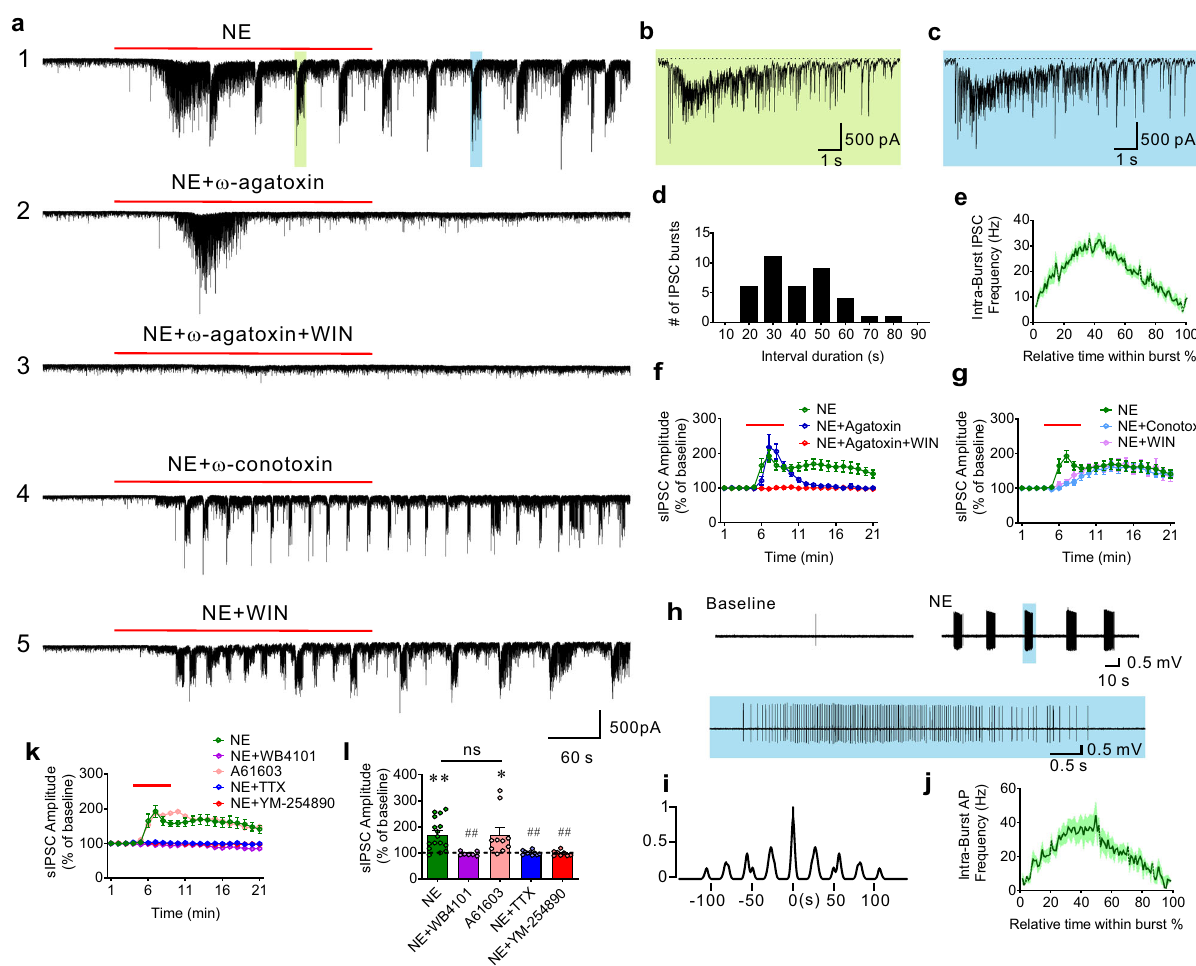
Fig. 3 α 1A adrenergic receptor activation of PV interneurons generates phasic IPSC bursts in BLA principal cells. a1 – 5 Representative recordings showing the effect of different treatments on NE-induced repetitive IPSC bursts in the BLA principal neurons. 1 . NE application induced phasic IPSC bursts following an initial increase in IPSCs. 2 . Inhibiting PV neuron-mediated transmission with the P/Q calcium channel blocker ω -agatoxin selectively blocked the NE-induced repetitive IPSC bursts, but not the initial increase in IPSCs. 3 . Co-application of ω -agatoxin and the CB1 receptor agonist WIN 55,212-2 blocked both the initial increase in IPSCs and the repetitive IPSC bursts. 4 . Pretreatment of a slice with the N-type calcium channel blocker ω -conotoxin selectively inhibited the initial increase in IPSCs induced by NE, but not the repetitive IPSC bursts. 5 . Application of the CB1 receptor agonist WIN 55,212-2 blocked the NE-induced initial IPSC increase but did not affect the repetitive IPSC bursts. b , c Expanded traces of individual IPSC bursts in a1 (indicated with green and blue shading), showing the fast acceleration in the intra-burst IPSC frequency and resulting depression in the baseline holding current (indicated with dashed lines) induced by NE. d Histogram showing the distribution of phase durations of NE-induced repetitive IPSC bursts. 10-s bins from time − 5 s to + 5 s. ( n = 38 bursts from 16 cells, 5 mice). e Mean (±SEM) instantaneous intra-burst IPSC frequency over the course of the NE-stimulated accelerating IPSC bursts ( n = 38 bursts from 16 cells, 5 mice). f Time course of the effect of blocking P/Q-type calcium channels and activating CB1 receptors on sIPSC amplitude. The NE-induced plateau increase in sIPSC amplitude (mean ± SEM) was blocked by ω -agatoxin (P/Q blocker), while the peak increase, corresponding to the NE-induced initial increase in IPSCs shown in a2 , was unaffected ( n = 10 cells from 4 mice). The ω -agatoxin-insensitive IPSCs were blocked by CB1 receptor activation with WIN 55,212-2 ( n = 8 cells from 3 mice), corresponding to the recording in a3 . g Time course of the effect of blocking N-type calcium channels and activating CB1 receptors on sIPSC amplitude (mean ± SEM). Both treatments selectively eliminated the NE-induced initial increase in IPSCs, with little effect on NE-induced repetitive IPSC bursts ( n = 12 and 10 cells from 4 and 3 mice, respectively), which corresponds to the recordings in a4 and a5 . h Representative loose-seal extracellular recording showing the NE-stimulated repetitive bursts of action potentials in a PV interneuron. A burst of action potentials indicated by the blue box was expanded below to show the accelerating intra-burst spike frequency. i Autocorrelation showing the rhythmicity of NE-induced AP bursts in the PV interneuron shown in h . j Mean (±SEM) instantaneous intra-burst action potential frequency over the course of PV neuron action potential bursts induced by NE ( n = 7 cells from 3 mice). k , l Mean (±SEM) change in sIPSC amplitude over time in response to NE ( n = 16 cells from 5 mice), NE + α 1A receptor antagonist WB4101 ( n = 7 cells from 4 mice), α 1A receptor agonist A61603 ( n = 10 cells from 4 mice), NE + TTX ( n = 10 cells from 5 mice), NE + Gq antagonist YM-254890 ( n = 8 cells from 3 mice); paired t -tests (two- tailed): NE vs. baseline, p = 0.0003, A61603 vs. baseline, p = 0.023; One-Way ANOVA, F(4, 46) = 6.22, p = 0.0004, Dunnett ’ s multiple comparisons test, NE vs. NE + WB4101, p = 0.0098, NE vs. A61603, p > 0.99, NE vs. NE + TTX, p = 0.0052, NE vs. NE + YM-254890, P = 0.0078; * p < 0.05, ** p < 0.01 vs. baseline, ## p < 0.01 vs. NE, ns not signi fi cant; values at time = 13 min were used to compare ω -agatoxin-sensitive IPSCs. Source data are provided as a Source Data fi